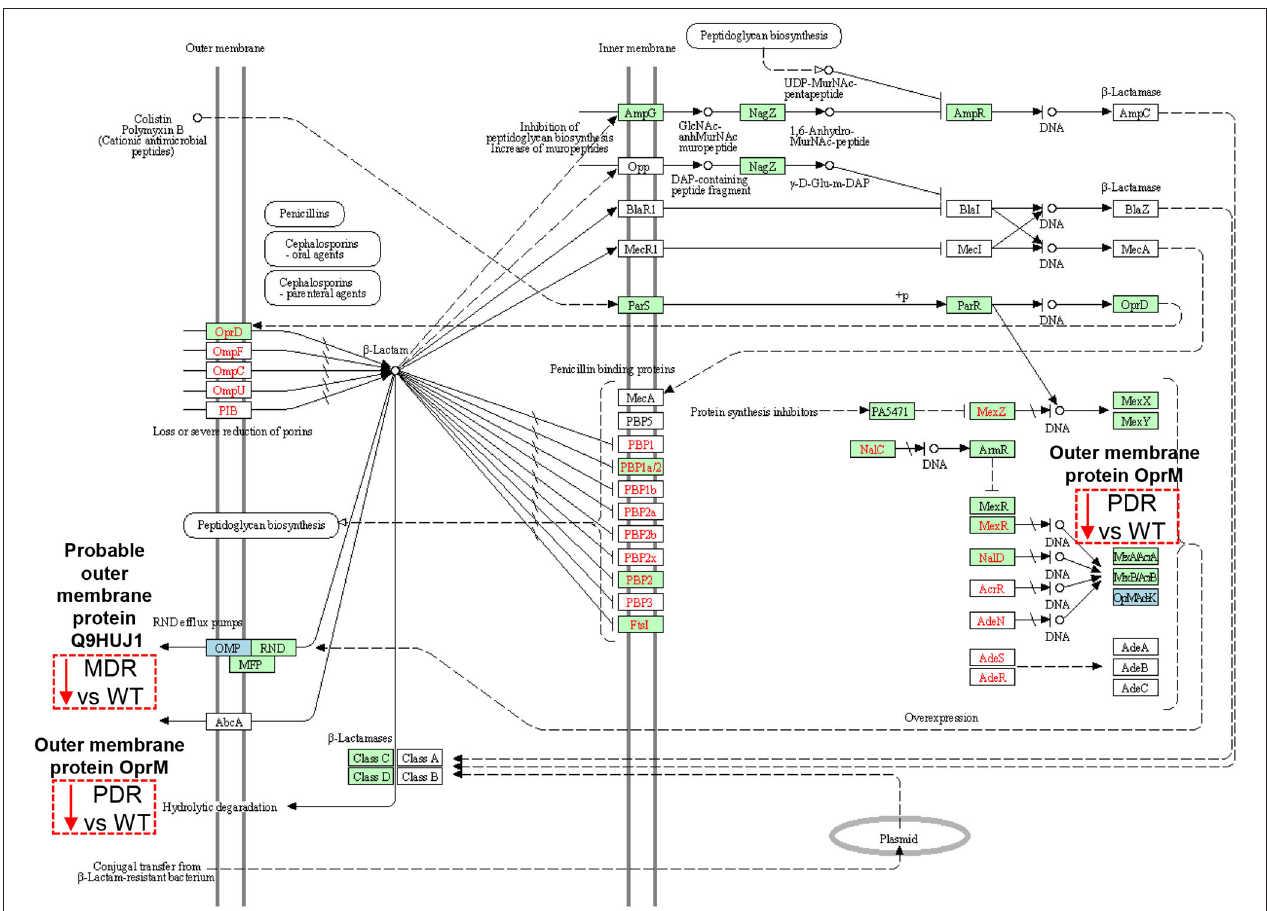
FIGURE 6 | Sketch of the β -Lactam resistance pathway. Image modified from pae01501 KEGG (release 99.0) pathway showing involved factors/effectors, their subcellular distribution and their molecular interactions, reactions and relation networks. MDR and PDR P. aeruginosa clinical strain identified proteins are represented by a dashed box along with their shift of expression compared to WT strains (red dashed box and downward arrow = under-expression). Among the outer membrane proteins, we identified a Probable outer membrane protein (UniProtKB code Q9HUJ1, KEGG identifier PA4974) and the Outer membrane protein OprM (Q51487, PA0427), both involved in the resistance-nodulation division (RND) efflux pump mechanisms at their outer membrane subcellular localization. OprM modulation may also result from intrinsic properties of organisms, through gene mutations, and through plasmid- and transposon-specified genes at the DNA level (OpMAdeK system). Light blue box = input protein, differentially expressed in MDR or PDR vs. WT. Green box = P. aeruginosa -specific pathway. Red characters = resistance associated gene